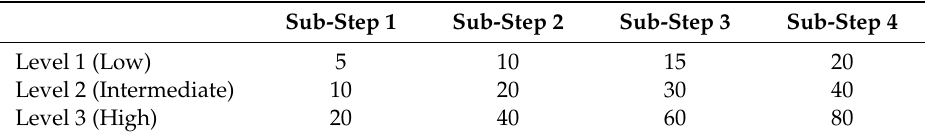
Table 3. Applied air pressures (kPa) at each sub-step of compression